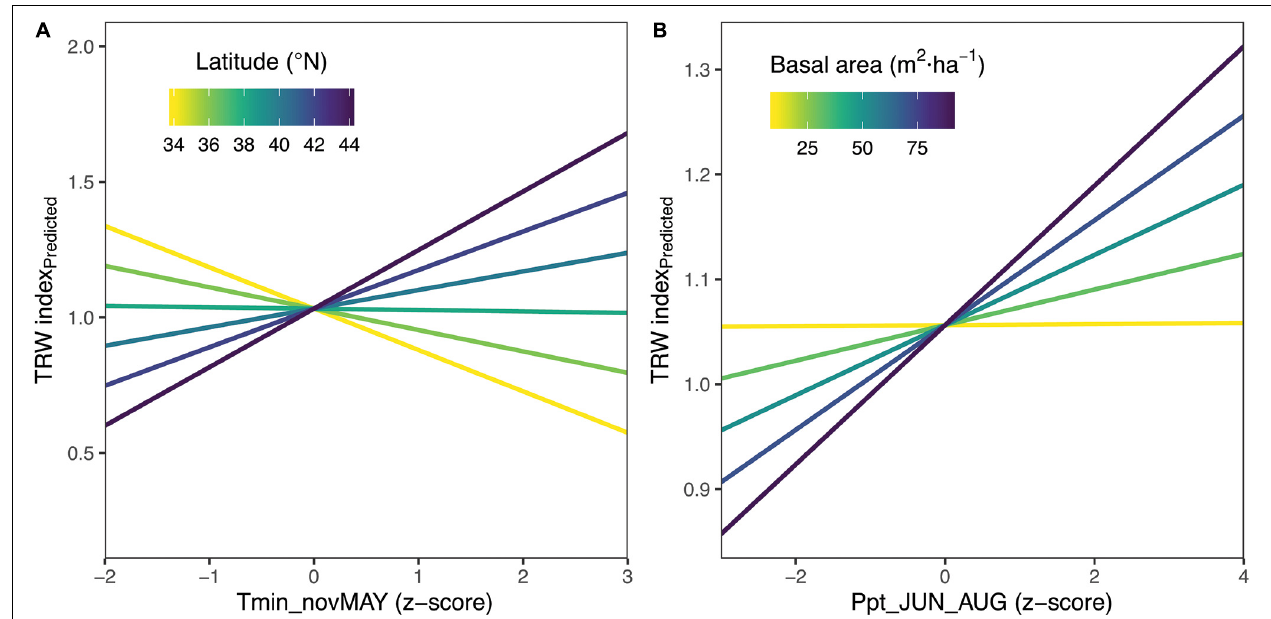
FIGURE 7 | Linear Mixed Effects Model Results – (A) The effect of prior Nov-current May average minimum monthly temperatures (Tmin_novMAY) increases with latitude. (B) The effect of total summer precipitation increases with increasing basal area of sampled forests. The latitude × tmin effect shown corresponds to basal area of 50m 2 /ha, which is the midpoint value of 11 populations with measured basal